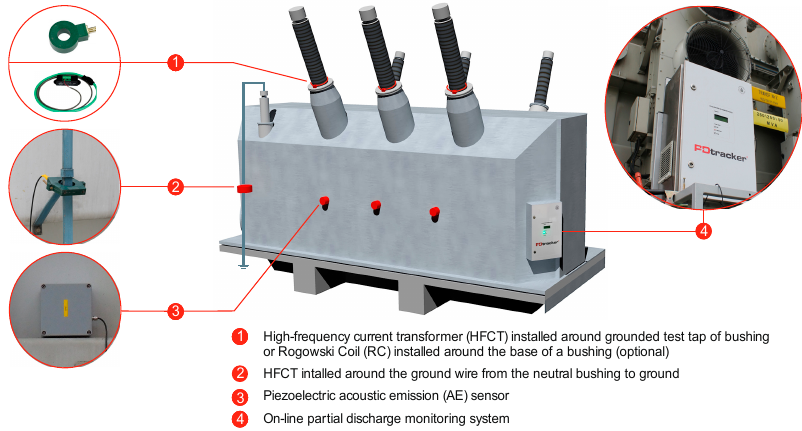
Figure 2. Arrangement of PD sensors on the monitored power transformer.